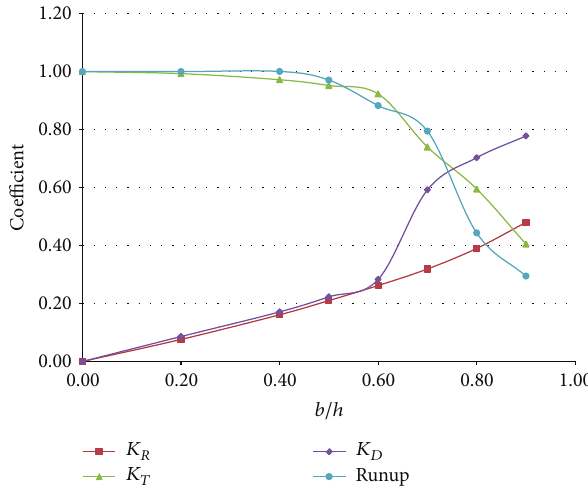
Figure 10: Variation of the runup coefficient with different wave